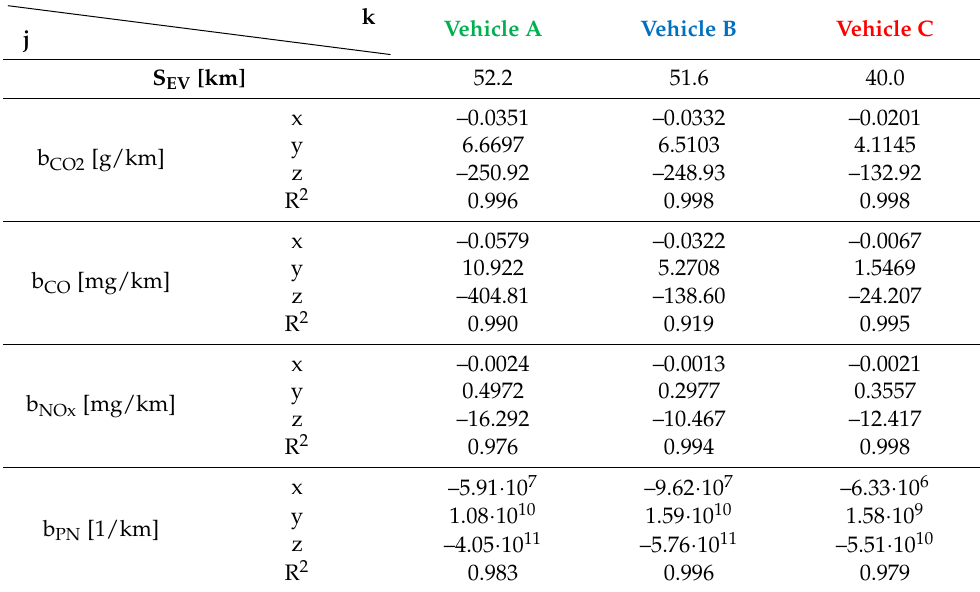
Table 8. Values of the equation indexes of the z, y, z multinomial and the coefficient of determination (R 2 ) for the road emission in the RDE test for each plug-in hybrid